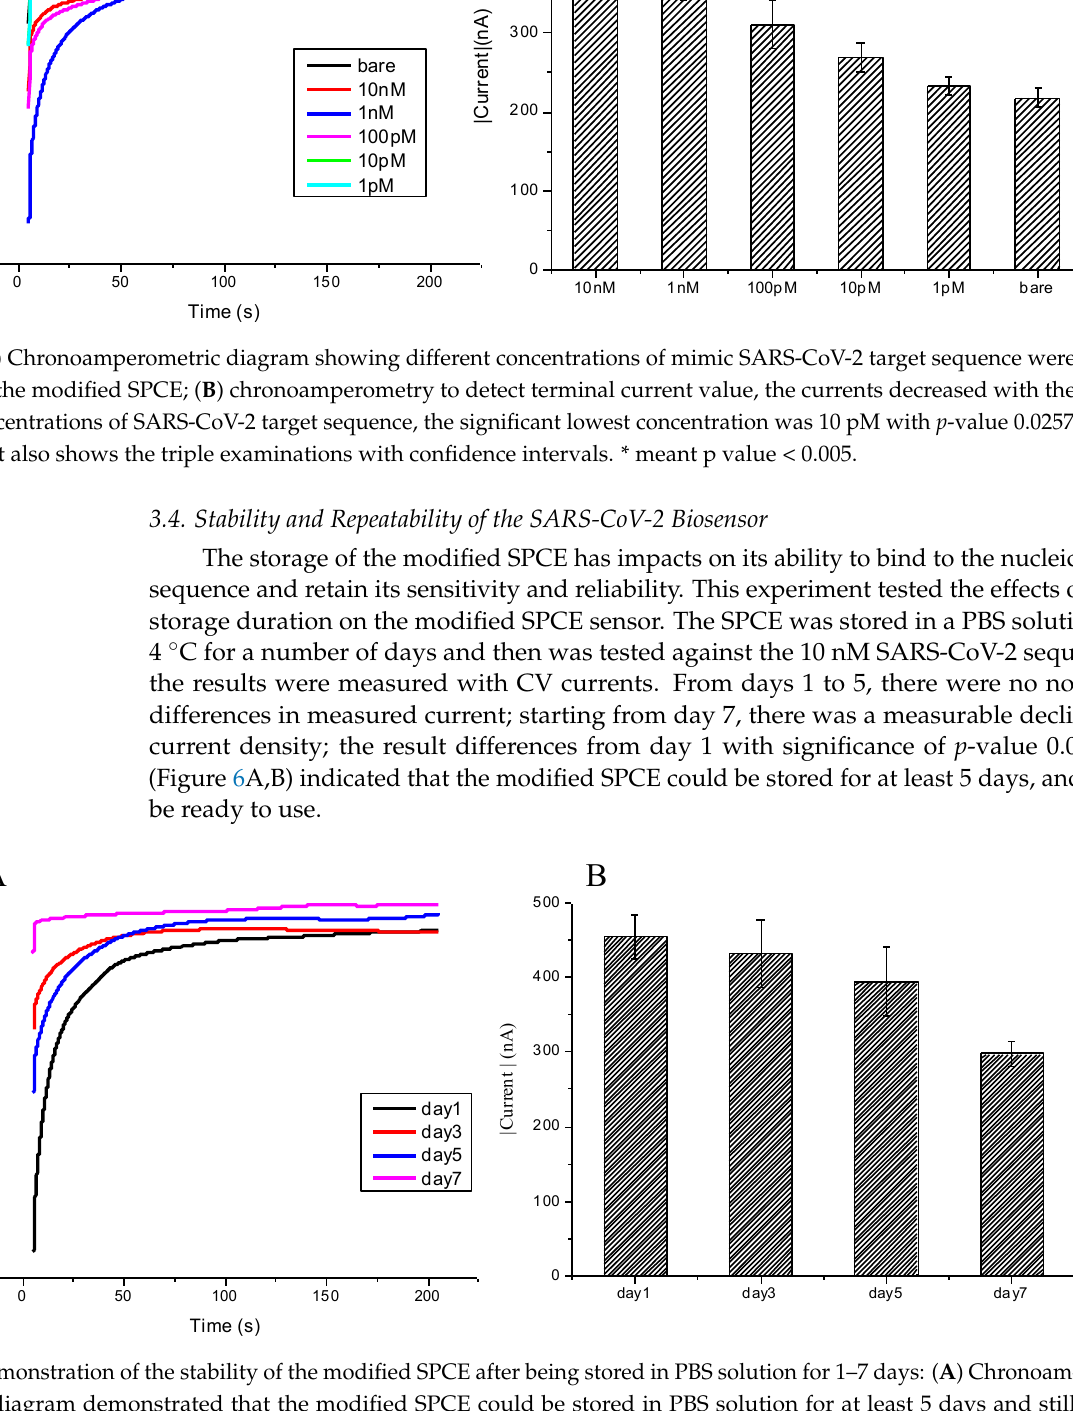
7 of 11 Figure 4. ( A ) Chronoamperometric diagram in different FITC probe concentrations; ( B ) the terminal current value in dif- ferent concentrations of FITC probe by chronoamperometry, and 1 μ m of FITC showed the best stability. The bar chart shows the triple examinations with confidence intervals. 3.3. Sensitivity and Reliability of the SARS-CoV-2 Biosensor To challenge the traditional technique of RT-PCR, which currently is considered to be the best and most reliable method to confirm whether a person has a SARS-CoV-2 in- fection, herein, we pursue to establish the lowest detectable concentration by simply test- ing a modified SPCE against a concentration gradient of SARS-CoV-2 nucleotides, i.e., 10 nM, 1 nM, 100 pM, 10 pM, 1 pM, and a bare SPCE as control; using CA, we measured current responses. As seen in (Figure 5B), the current directly correlates to the concentra-